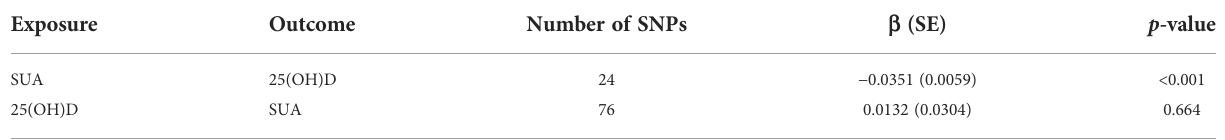
TABLE 2 The effect of the GRS instrument of SUA on 25(OH)D and the effect of the GRS instrument of 25(OH)D on SUA.